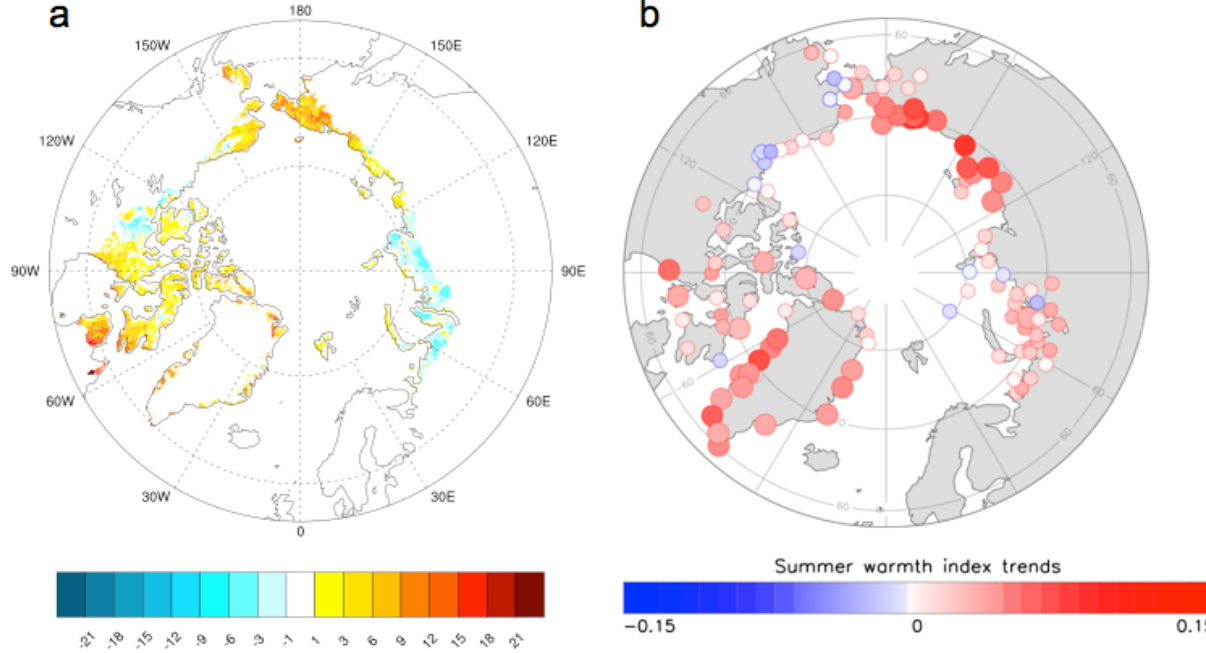
Figure A1. Magnitude trends for land-surface summer warmth index (SWI) (°C month), based on ( a ) satellite data and ( b ) station data. The total trend magnitude (regression times 27 years) covers the 1982–2008 period. Larger circles in panel b indicate larger statistical significance than smaller